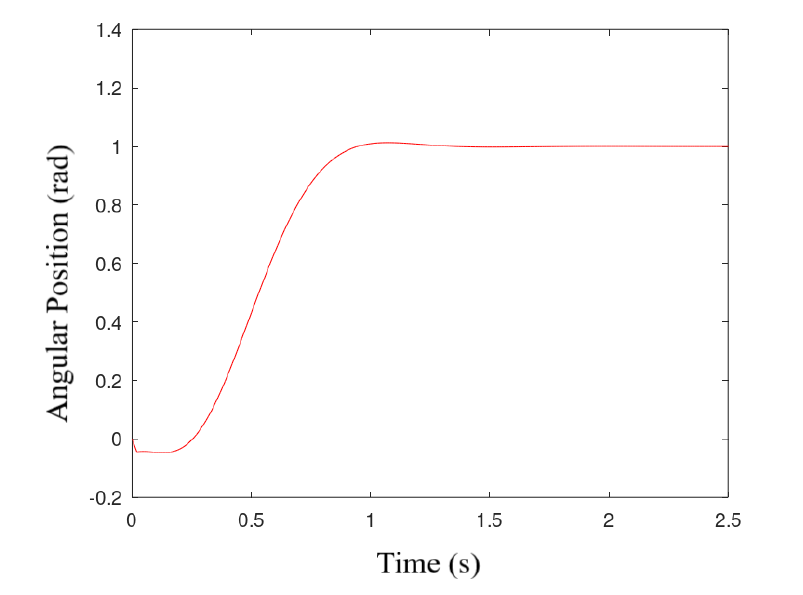
Figure 9. Non-Rigid joint simulated controller.